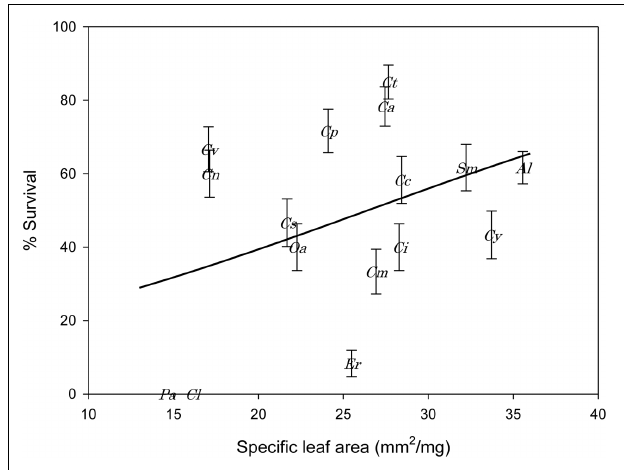
FIGURE 3 | Mean ( ± SE) percent survival of Cassida rubiginosa in relation to specific leaf area of the 16 Cardueae test species. The relationship between % survival and specific leaf area (SLA) is given by the equation, % survival = 100/[1 + exp(1.770 – 0.0670 × SLA)]. Ct, Carduus tenuiflorus ; Ca, Cirsium arvense ; Cp, Cirsium palustre ; Cv, Cirsium vulgare ; Sm, Silybum marianum ; Al, Arctium lappa ; Cn, Carduus nutans ; Cc, Cynara cardunculus ; Cs, Cynara scolymus ; Cy, Centaurea cyanus ; Ci, Centaurea nigra ; Oa, Onoporodum acanthium ; Cm, Centaurea macrocephala ; Er, Echinops ritro ; Pa, Ptilostemon afer ; Cl, Carthamus lanatus .